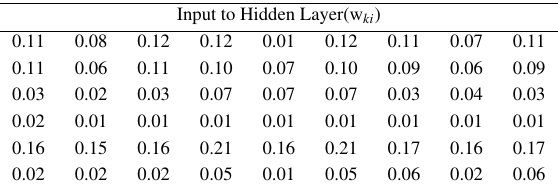
Table 2. NFRGNN with initial connection weights in fuzzy case for Telugu vowel.